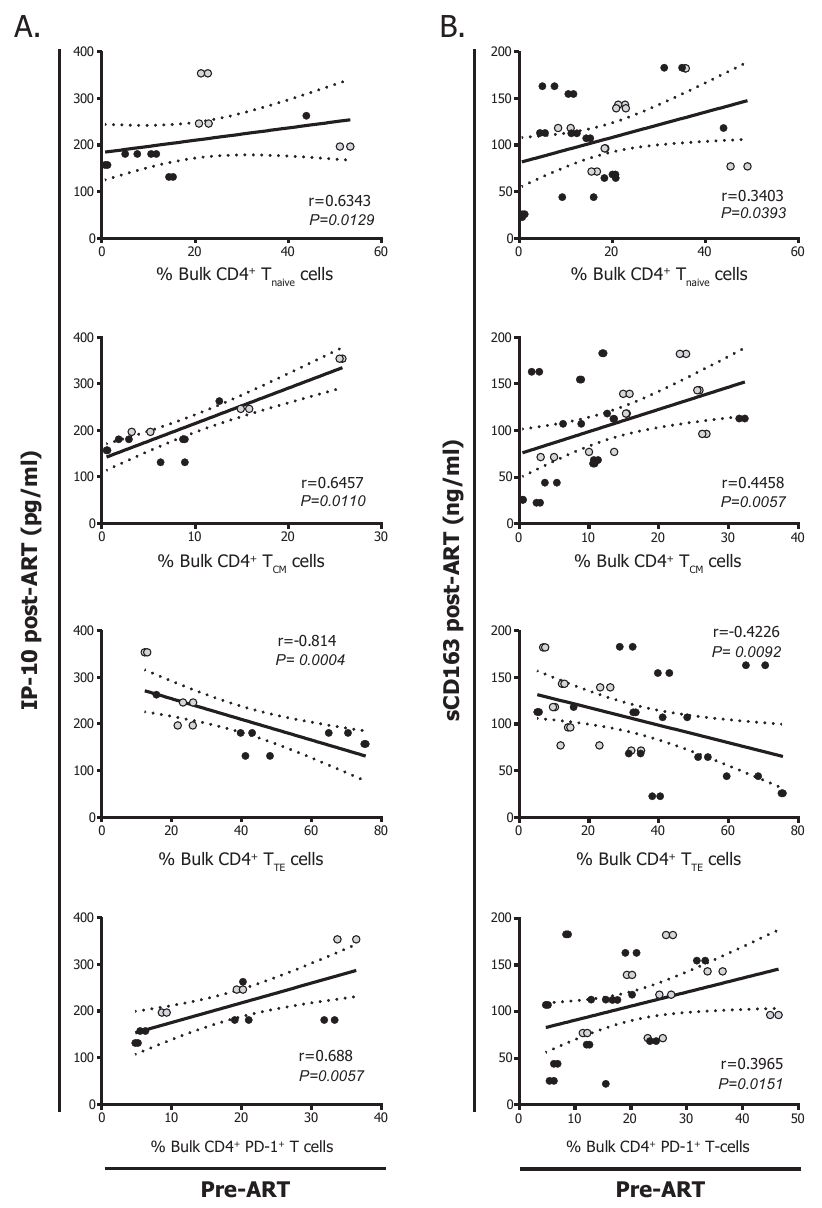
Figure 5: Correlations analysis between the phenotype of CD4+ T cells pre-cART and inflammation levels post-cART . Correlations between the proportions of CD4+ Tnaive, TCM, TTE and PD-1+ cells pre-cART and plasma levels of IP-10 ( A ) and soluble CD163 ( B , sCD163) measured post-ART. Black dots represent ET participants and gray dots represent DT participants. The r and P values correspond to Spearman’s test. SCM: stem-cell memory, CM: central memory, EM: effector memory, TE: terminal